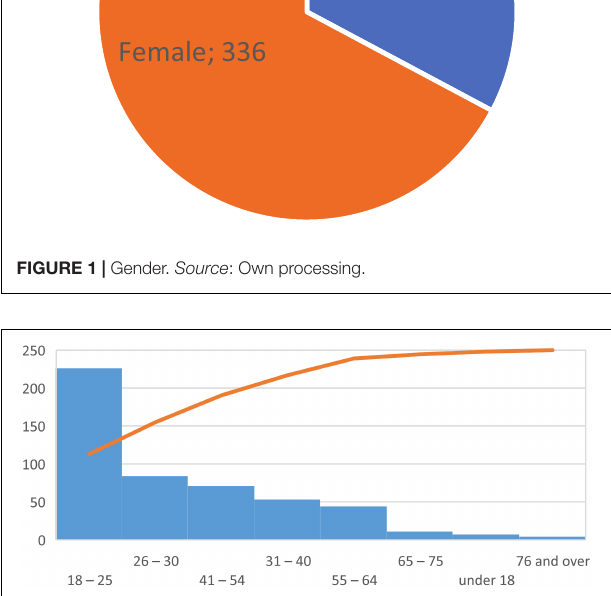
FIGURE 2 | Age. Source : Own processing.